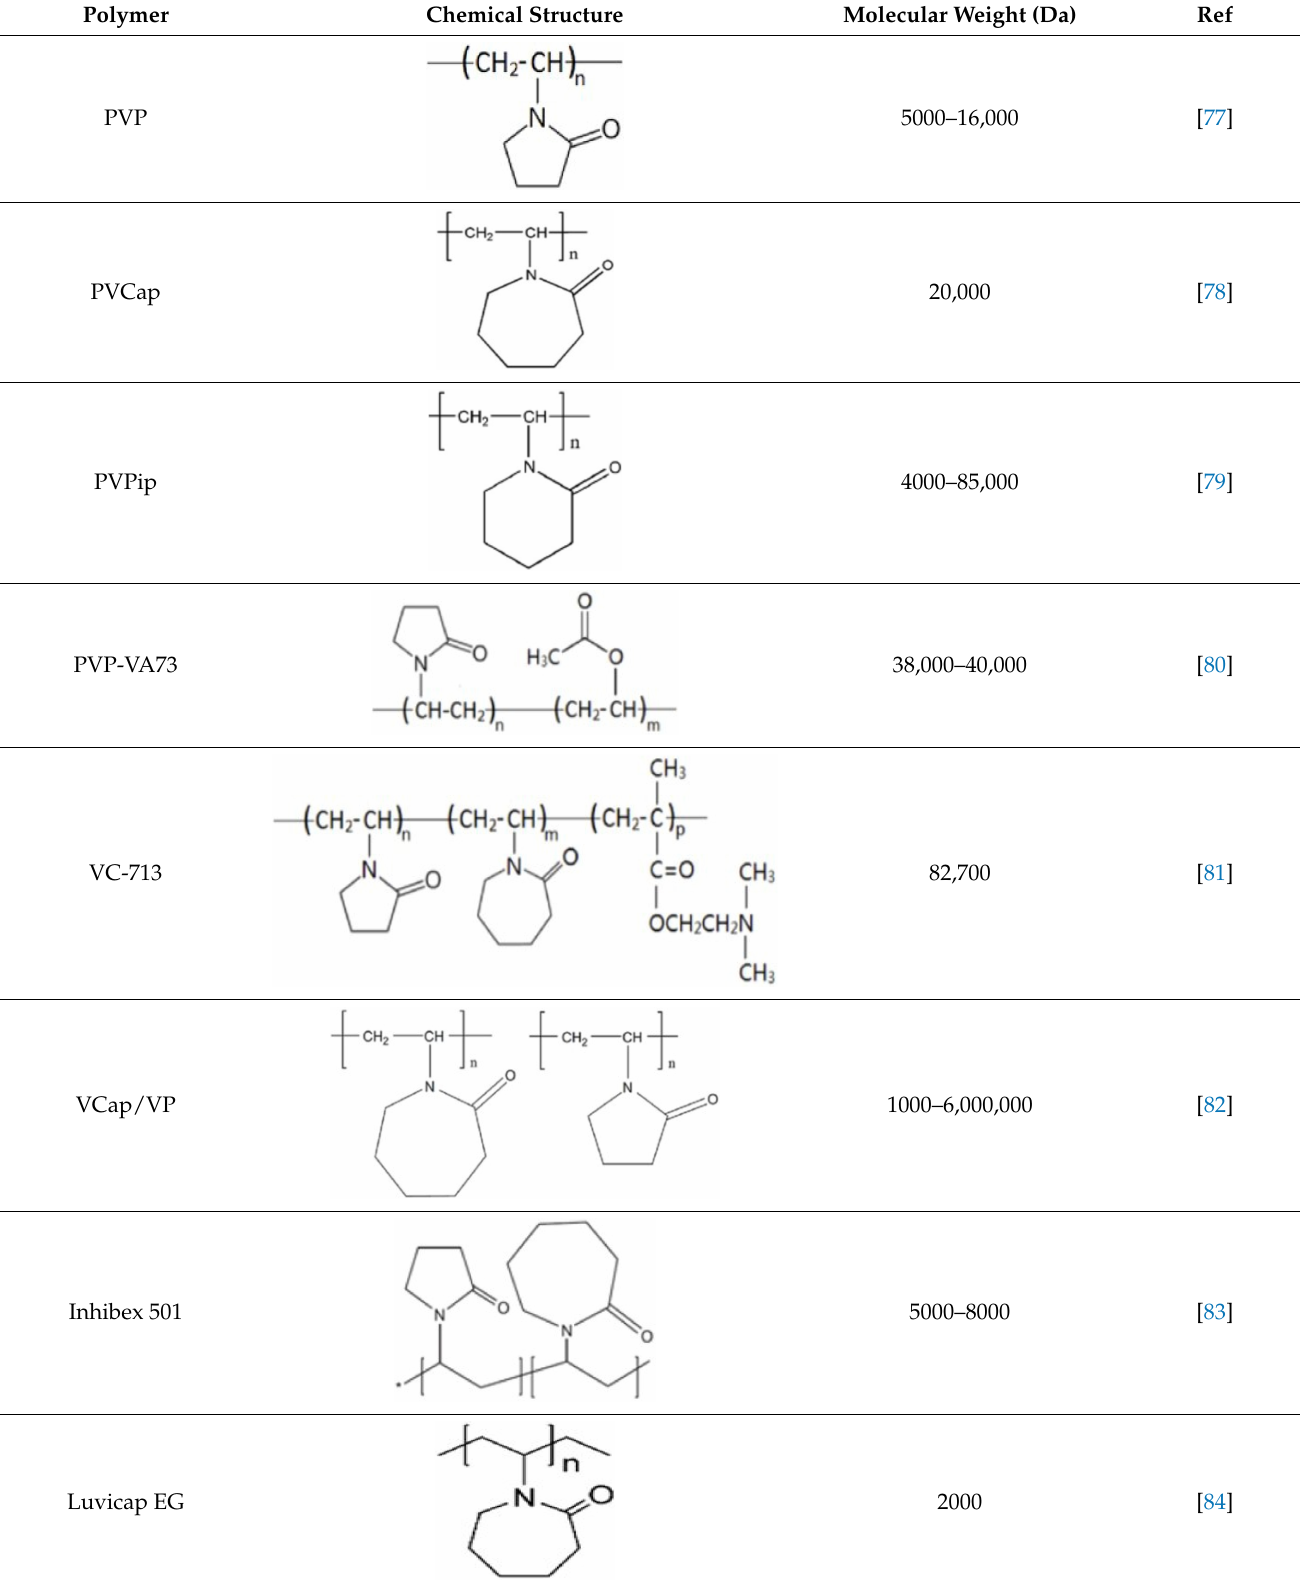
Table 2. The most commonly applied polymeric KHIs in the oil/gas